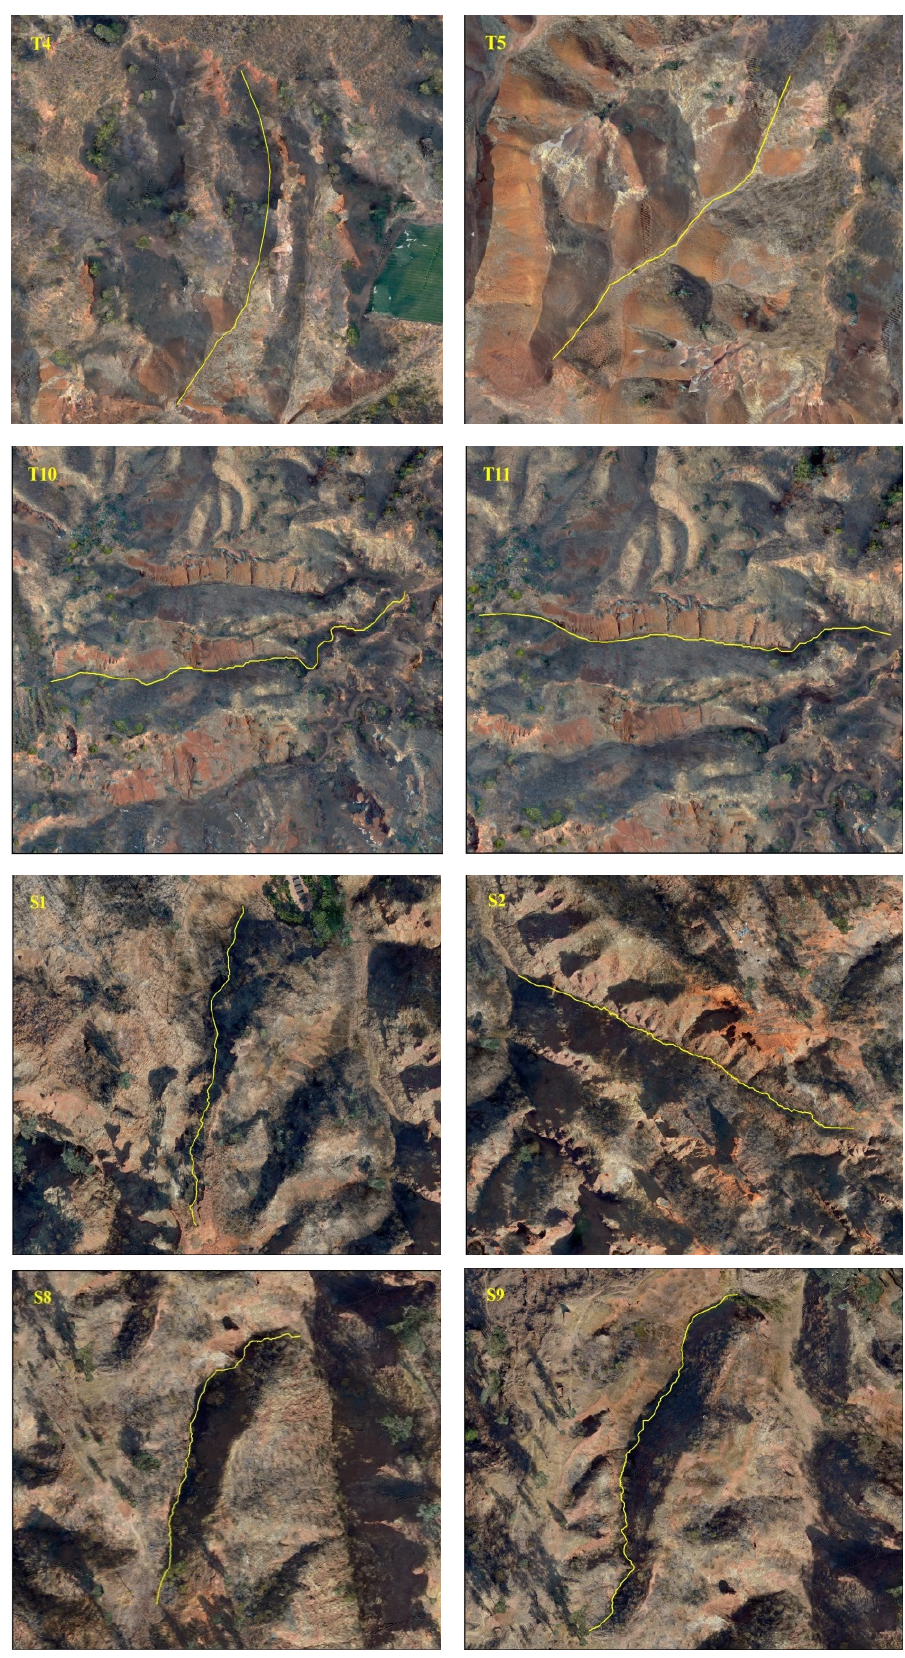
Figure 10. The gullies’ locations.